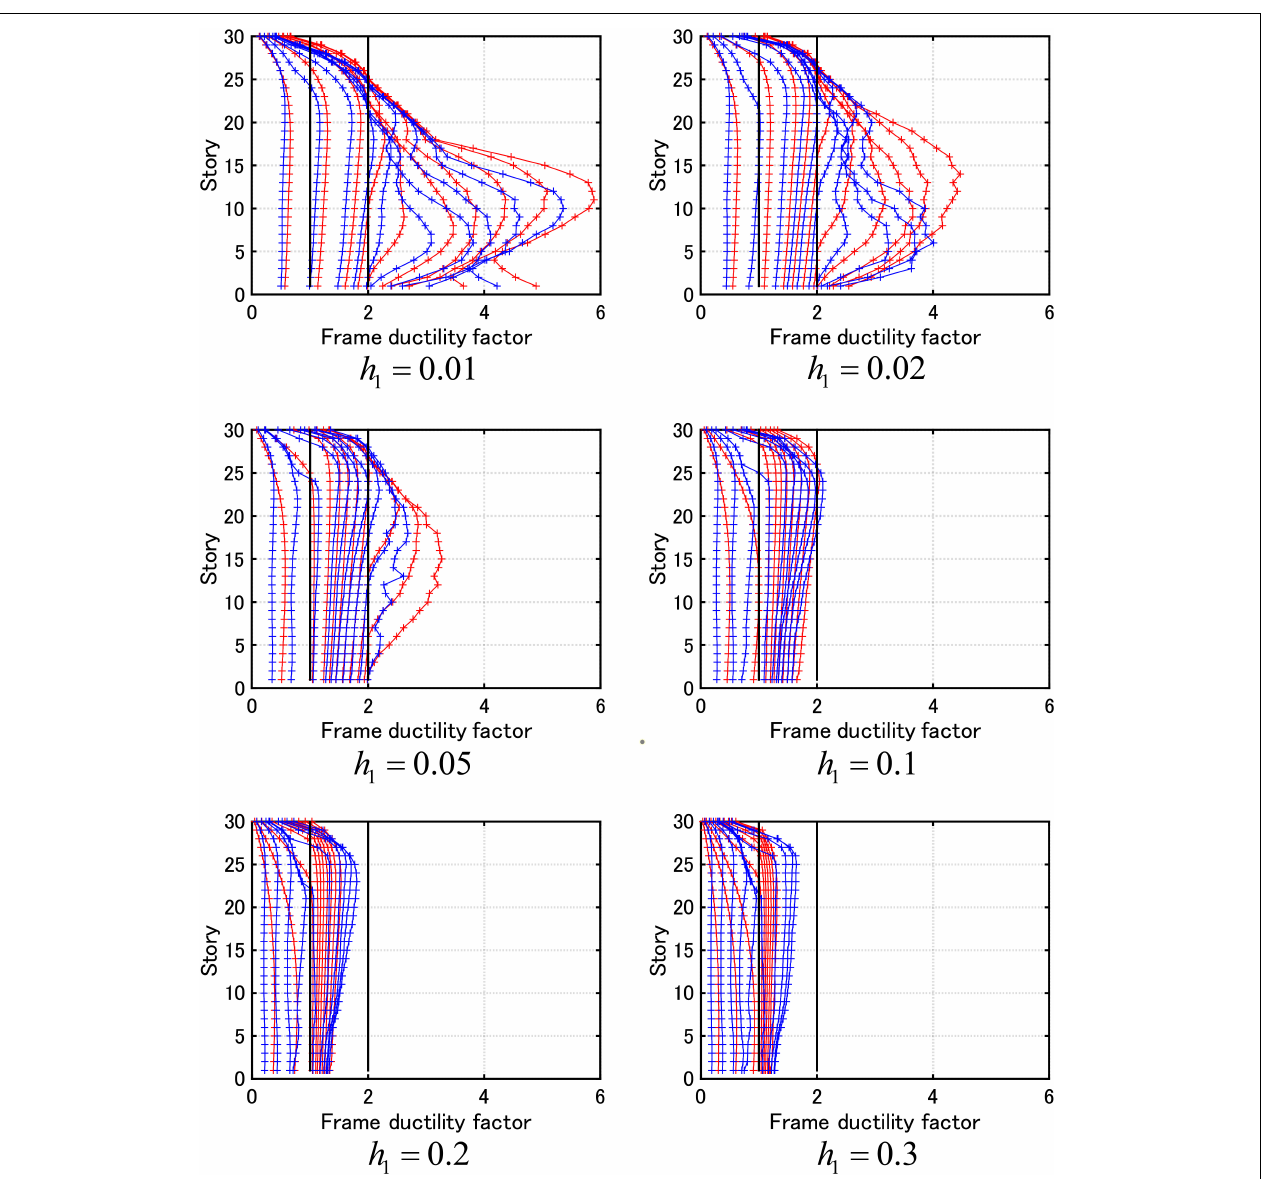
FIGURE 10 | Double impulse pushover (DIP) analysis ( V = 0.3–3.0 (m/s) with increment 0.3 (m/s)) for MDOF systems with HVH system for various damping levels h 1 = 0 . 01 , 0 . 02 , 0 . 05 , 0 . 1 , 0 . 2 , 0 . 3 of viscous dampers and with DHD system of equivalent damper quantity of DSA (using Eq. (18) for V = 1.0 (m/s)) ( − HVH; −